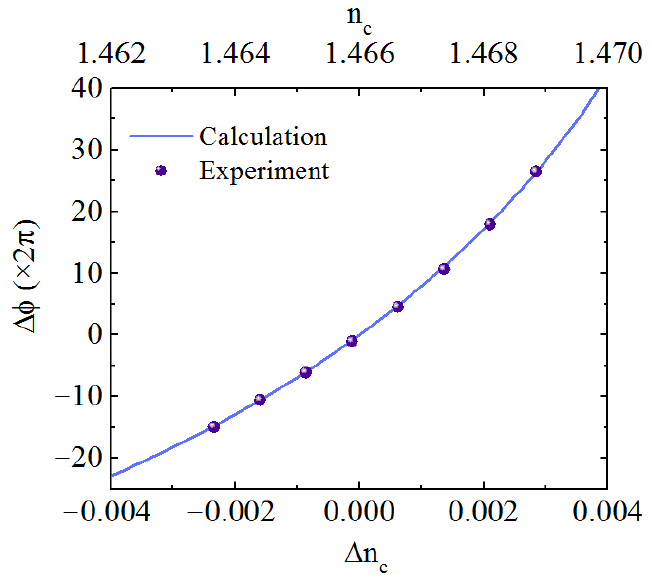
Figure 7. Phase change as a function of ∆ n c ; dots: experiment, solid line: